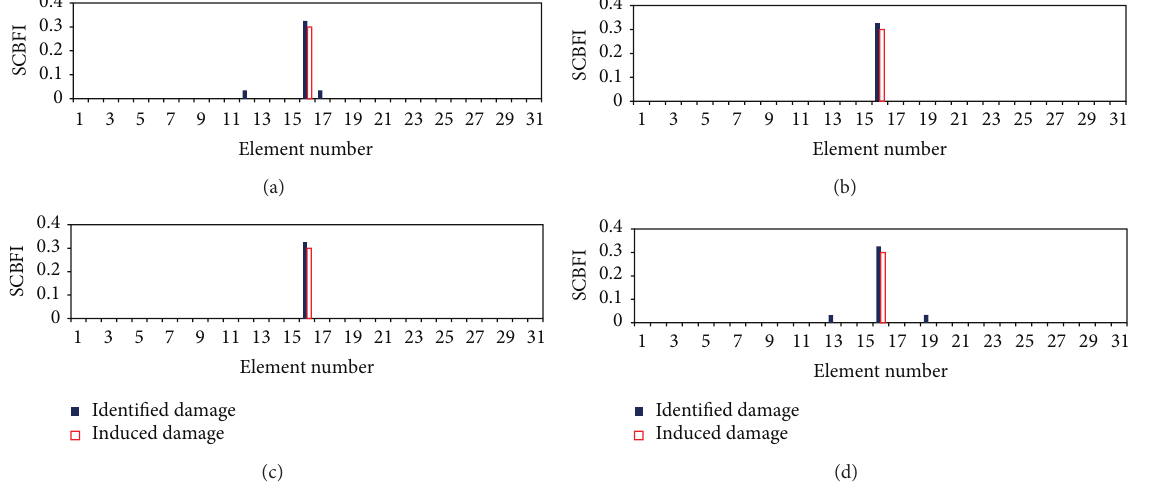
where SMH 𝑖 𝑒 is the strain of 𝑒 th element related to 𝑖 th column of FMH; SMD 𝑖 𝑒 is the strain of 𝑒 th element related to 𝑖 th column of FMD; {𝑑 𝑖 𝑒ℎ } and {𝑑 𝑖 𝑒𝑑 } are the nodal displacement vectors of 𝑒 th element, associated with the 𝑖 th column of flexi- bility matrix for healthy and damaged structure, respectively; 𝜃 𝑒 is the angle between local and global coordinates of element, and 𝐿 𝑒 is the length of 𝑒 th